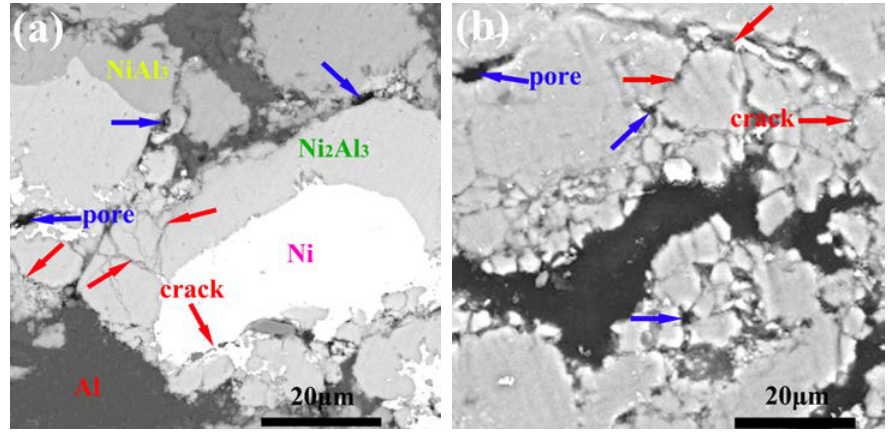
Figure 19. Microstructure of Ni/Al coatings as-sprayed at 450 °C and annealed at ( a ) 650 °C for 10 h and ( b ) 650 °C for 30 h.